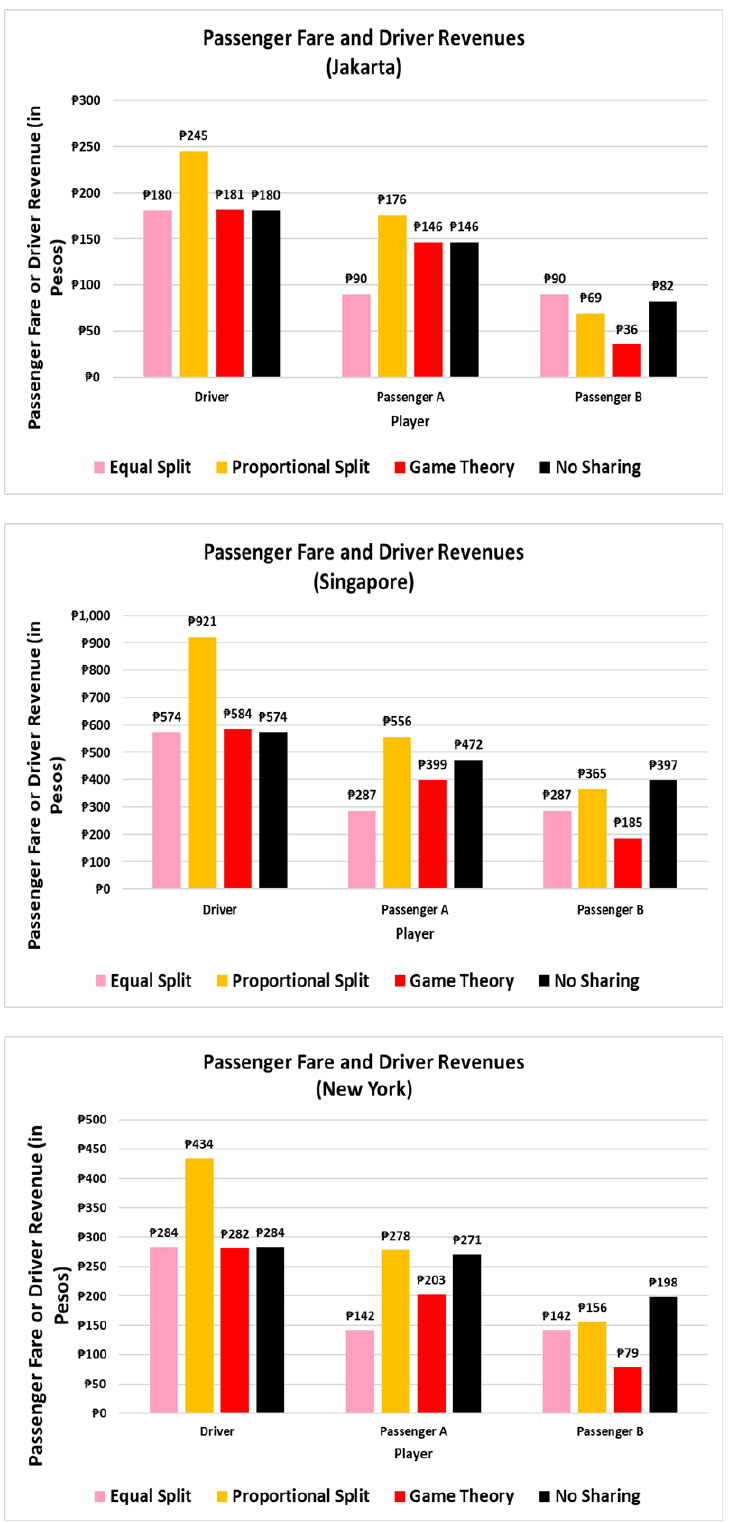
Figure 7. Average Passenger Fare and Driver Revenue in Jakarta ( top ), Singapore ( middle ), and New York ( bottom